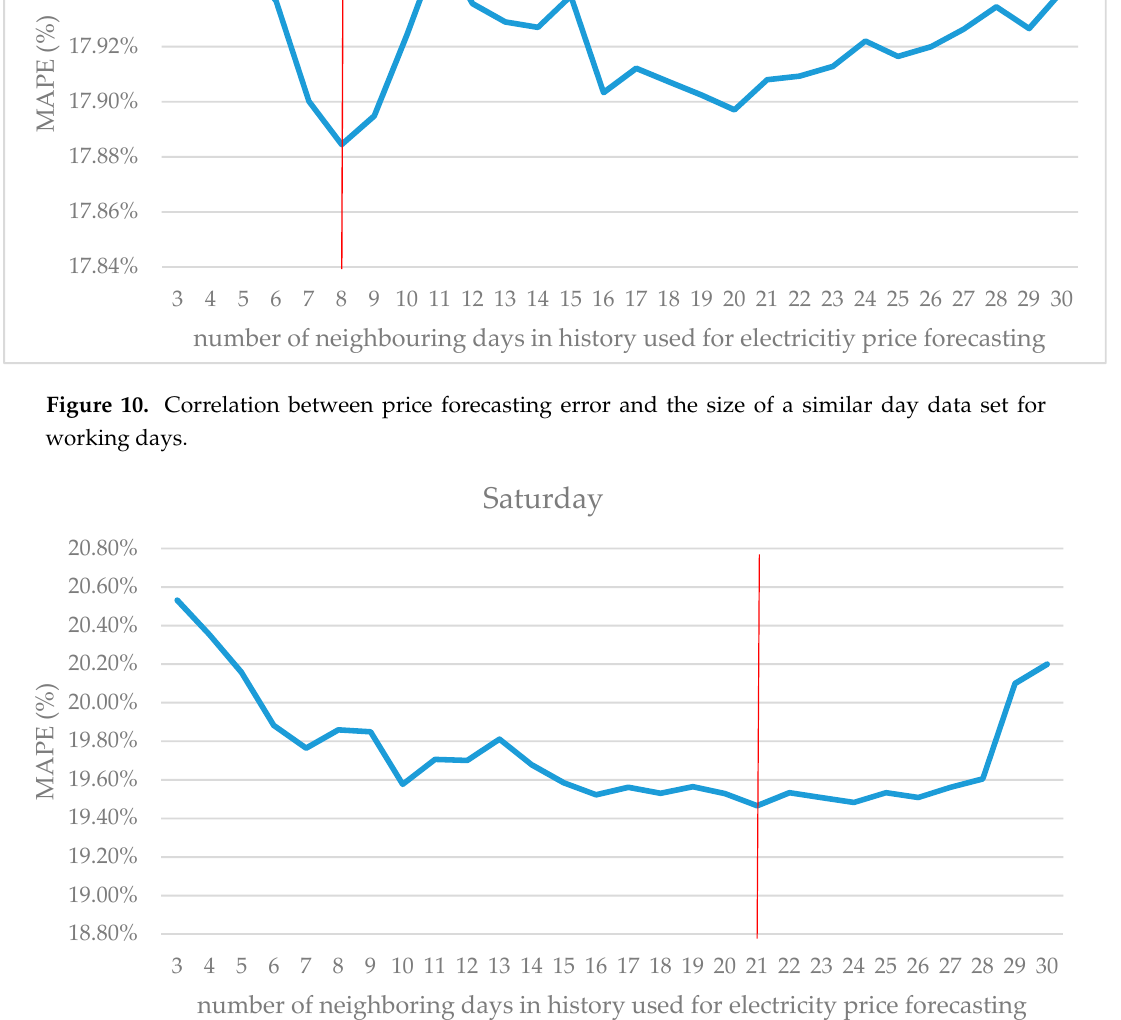
Figure 11. Correlation between price forecasting error and the size of a similar day data set for Saturday.